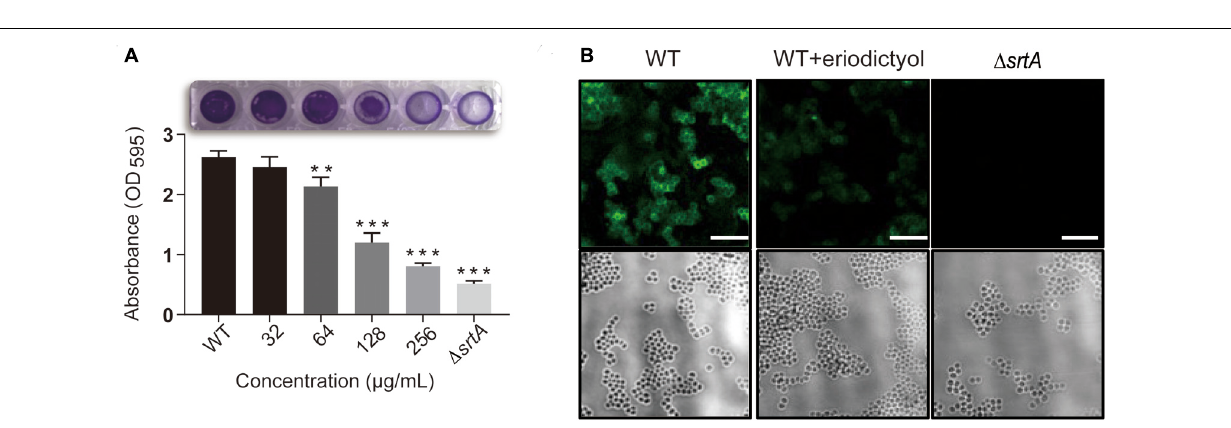
Frontiers in Microbiology |